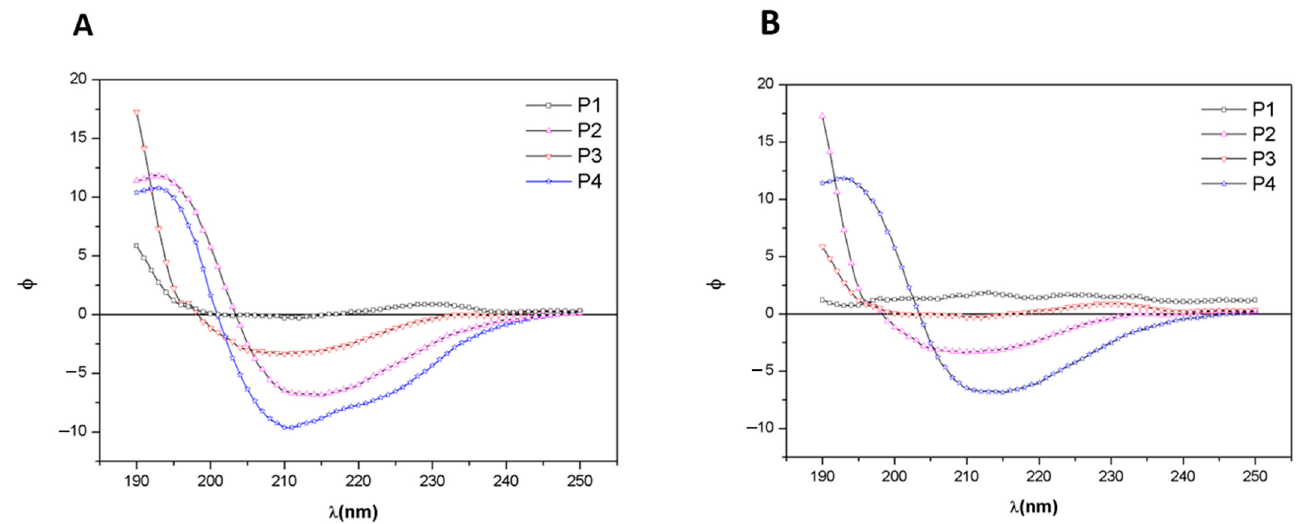
Figure 4. Circular dichroism (CD) spectra of extracts obtained from protocols P1, P2, P3, and P4 of the species ( A ) C. caribensis ( B ) A. fulva . The data are represented as dichroic ellipticity ([ Θ ]) versus wavelength.